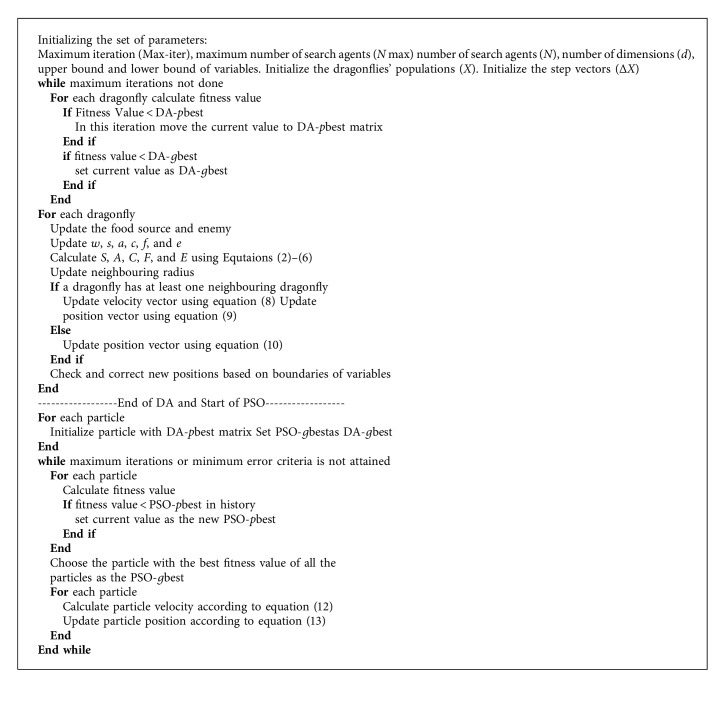
Pseudocode for MHDA [26].